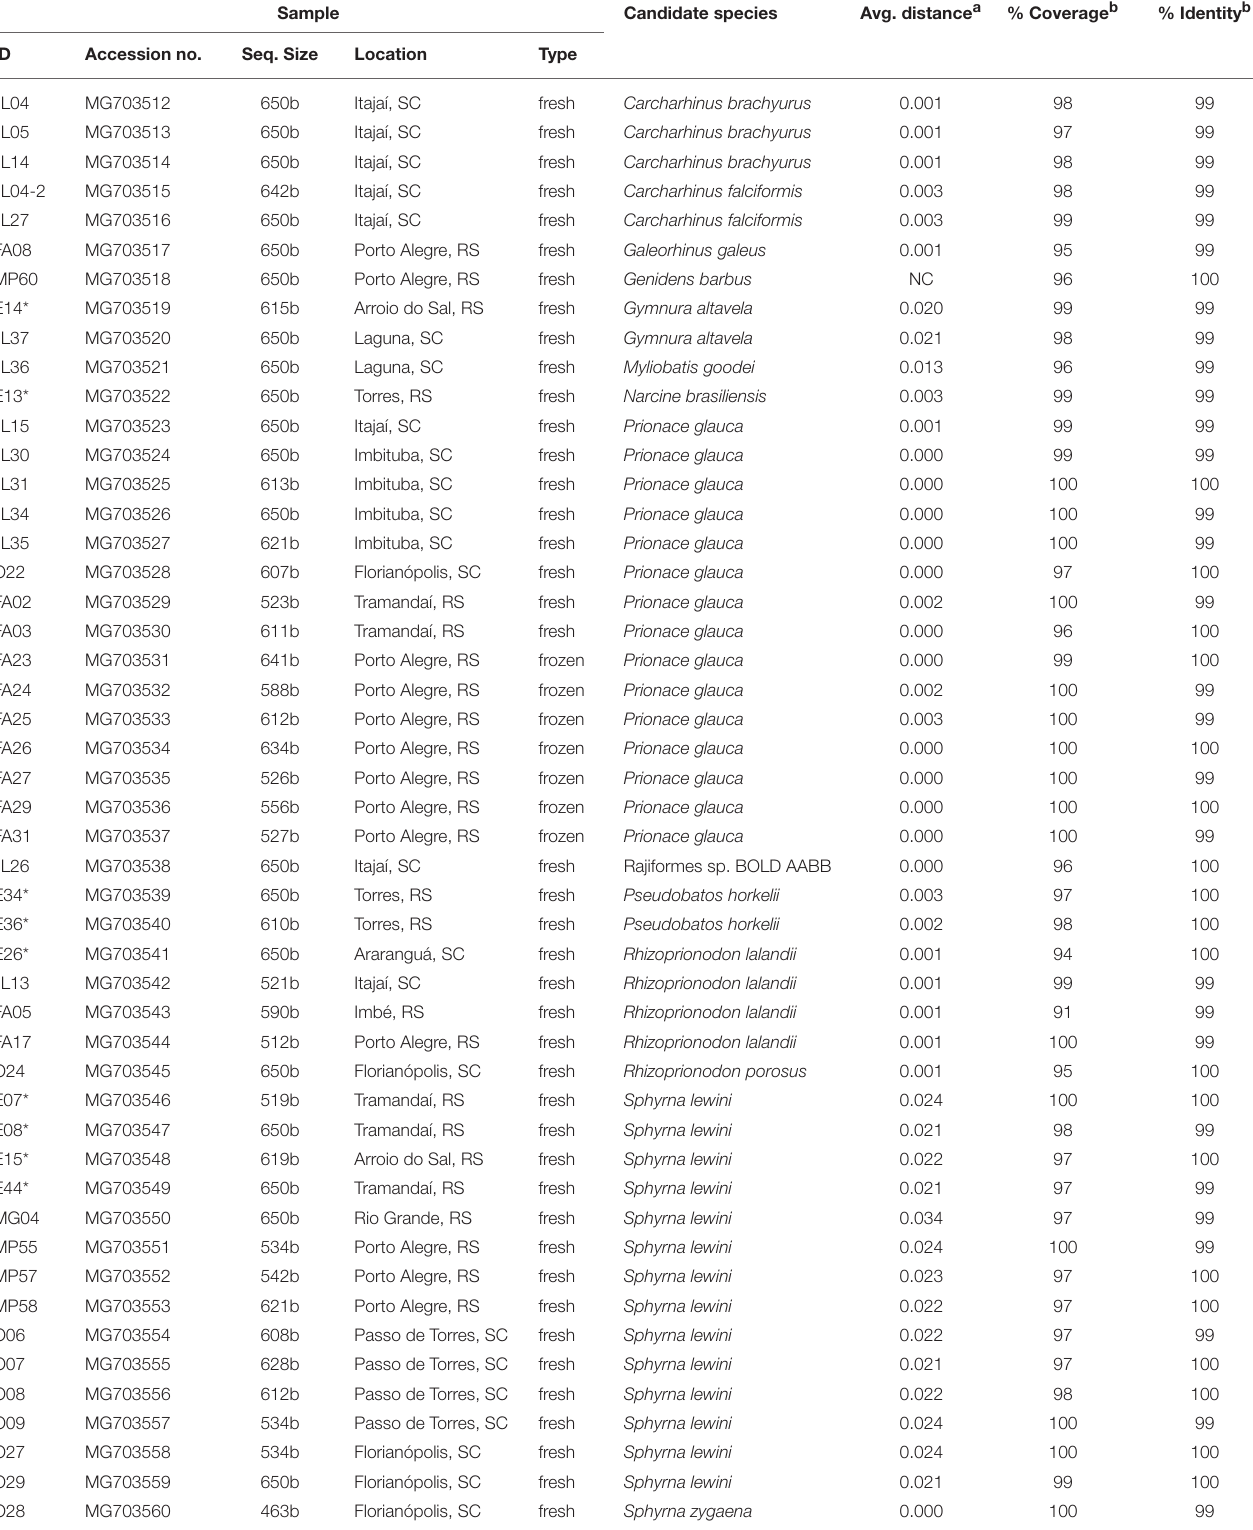
TABLE 1 | Sample information, species identification, average genetic distance, and results from the BLAST search.